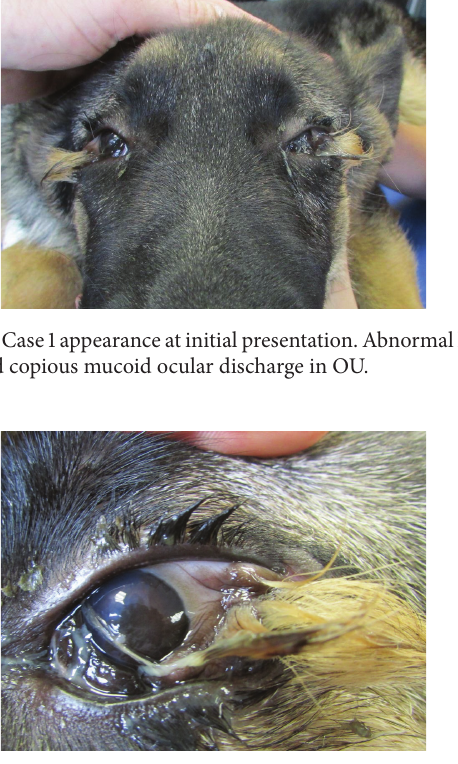
Figure 2: Case 1 appearance OS. Hair is present in the conjunctival fornix and extends beyond the lateral canthus. Ocular discharge and corneal pigmentation are also